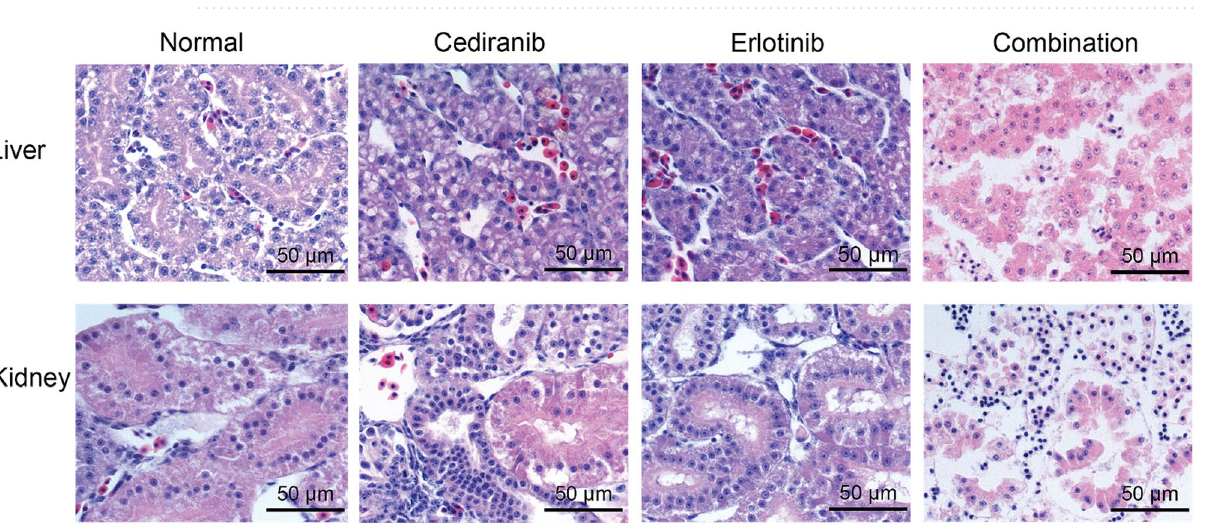
Figure 4. Comparison of in vitro, quail egg ex ovo xenograft and mouse in vivo xenograft results. ( a , b ) In vitro drug curves, each point has n = 4 replicates. ( c , d ) For the ex ovo drug curves, each concentration has n = 4–6 replicates. ( e ) The murine xenograft survival analyses for HB243 (n = 4) defined an event occurrence as tumor volume equal or greater than 0.75 cc, and a significant difference observed between treatment and control groups with a p = 0.031 using the Mantel-Cox test. ( f ) The survival of HepG2 bearing mice (n = 3) using the same criteria did not have a difference between treatment and control groups with p = 0.685. ( g ) Shown is the experiment timeline for drug dosing in mouse xenograft studies.